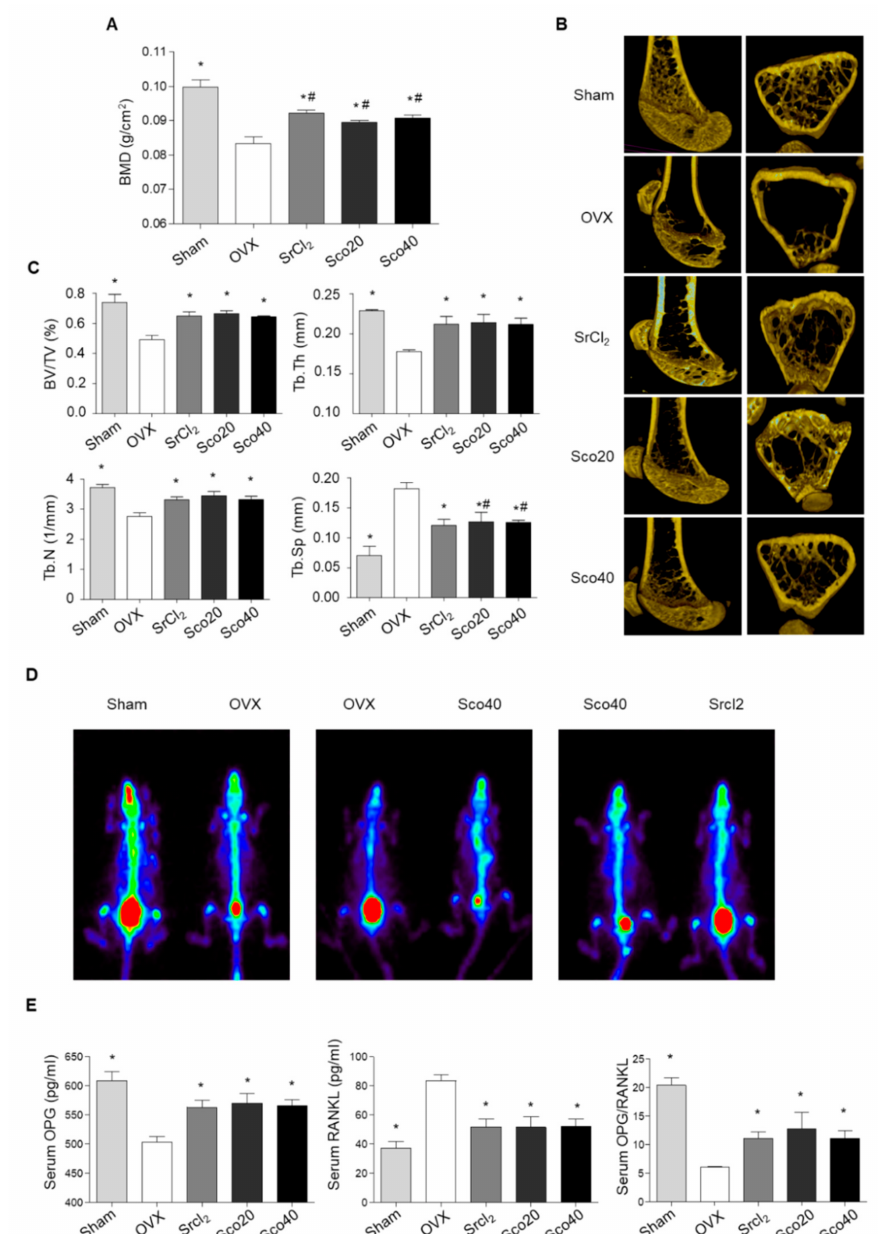
Figure 6. Scopolin treatment prevented ovariectomized (OVX)-induced bone loss in mice. The OVX mice were treated with either SrCl 2 (10 mg.kg − 1 day − 1 ) or scopolin (20 or 40 mg.kg − 1 day − 1 ) for 12 weeks. Sham: Sham-operated, OVX: Non-scopolin-treated mice. ( A ) The right femur bone mineral density (BMD) was measured using a PIXI-mus bone densitometer at 12 weeks. ( B ) Transverse micro-CT images of the right femur and ( C ) bone volume fraction (BV / TV), trabecular thickness (Tb.Th), trabecular number (Tb.N), and trabecular spacing (Tb.Sp) were analyzed. ( D ) Technetium Tc-99m hydroxymethylene diphosphonate (HDP) bone scan was taken with an Inveon single-photon emission computerized tomography (SPECT) scanner. ( E ) Osteoprotegerin (OPG) and of receptor activator of nuclear factor- κ B (NF- κ B) ligand (RANKL) were measured using enzyme-linked immunosorbent assay (ELISA) and the ratio of OPG / RANKL was calculated. * p < 0.05 vs. OVX control and # p < 0.05 vs. OVX control (Tukey’s honest significant di ff erence post hoc test, analysis of variance). All experiments were repeated three times, except the measurement of skeletal technetium (Tc-99m) HDP uptake on planar HDP bone, which was performed